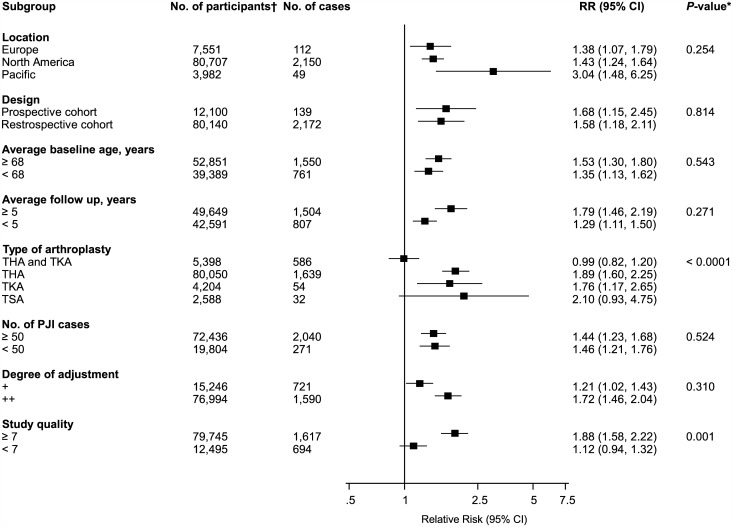
Risk of periprosthetic joint infection in body mass index comparison group ≥ 30 versus < 30 kg/m2, grouped according to several study characteristics.CI, confidence interval (bars); *, P-value for meta-regression; PJI, periprosthetic joint infection; THA, total hip arthroplasty; TKA, total knee arthroplasty; TSA, total shoulder arthroplasty; †, are number of participants or arthroplasties.